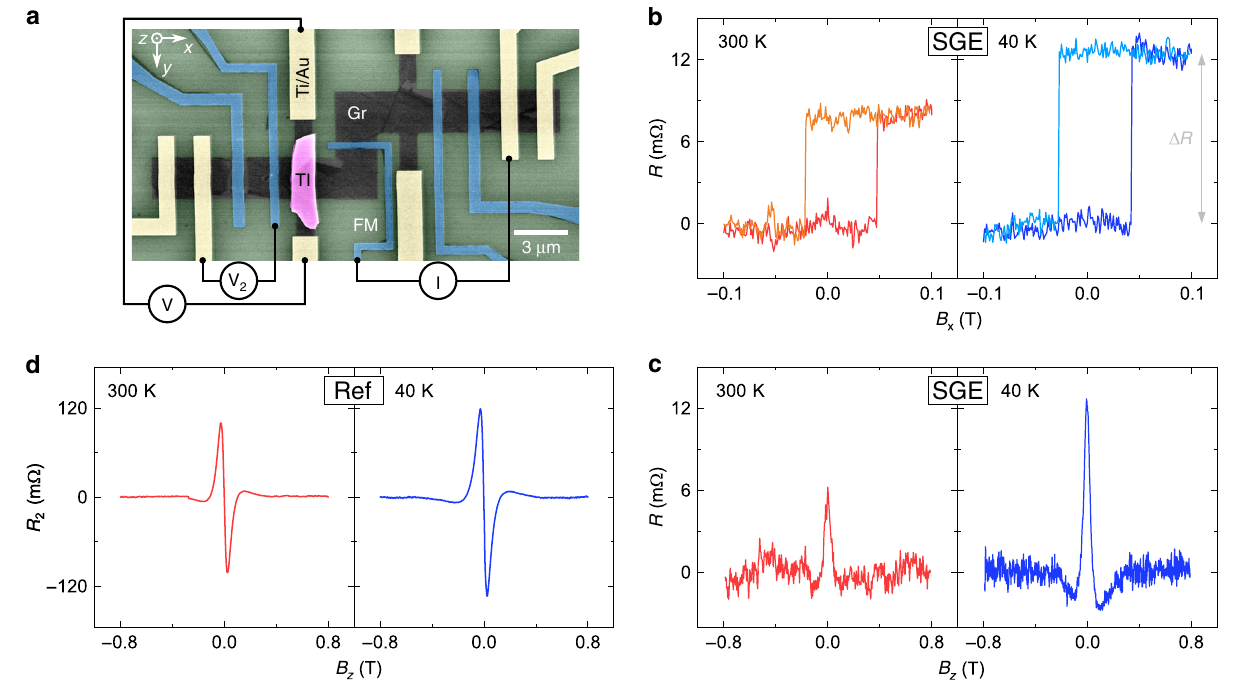
Fig. 2 Measurements of the spin-galvanic effect in a graphene-topological insulator heterostructure. a A colored scanning electron microscopy picture of a hybrid device consisting of a modi fi ed Gr Hall bar structure with a TI fl ake placed on top of one of the crosses. The device is contacted by ferromagnetic (FM) tunnel electrodes (TiO 2 /Co, blue) and non-magnetic electrodes (Ti/Au, yellow). The nonlocal measurement con fi guration includes the spin current injection from a FM into graphene and the SGE detection as a voltage signal V across the Gr – TI Hall cross by non-magnetic contacts. In addition, a reference spin voltage V 2 is detected by a second ferromagnet. b The SGE signal R = V / I measured with the in-plane magnetic fi eld B x at T = 300 K (red) and T = 40 K (blue). c The SGE detected via spin precession with the out-of-plane fi eld B z . d Reference Hanle spin precession measurements R = V I obtained with a ferromagnetic detector. All the measurements were performed with the back gate voltage V 2 2 / − 500 µ